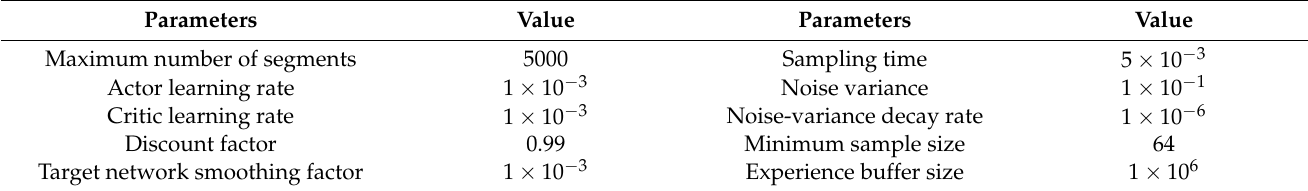
Table 4. Training hyperparameters.